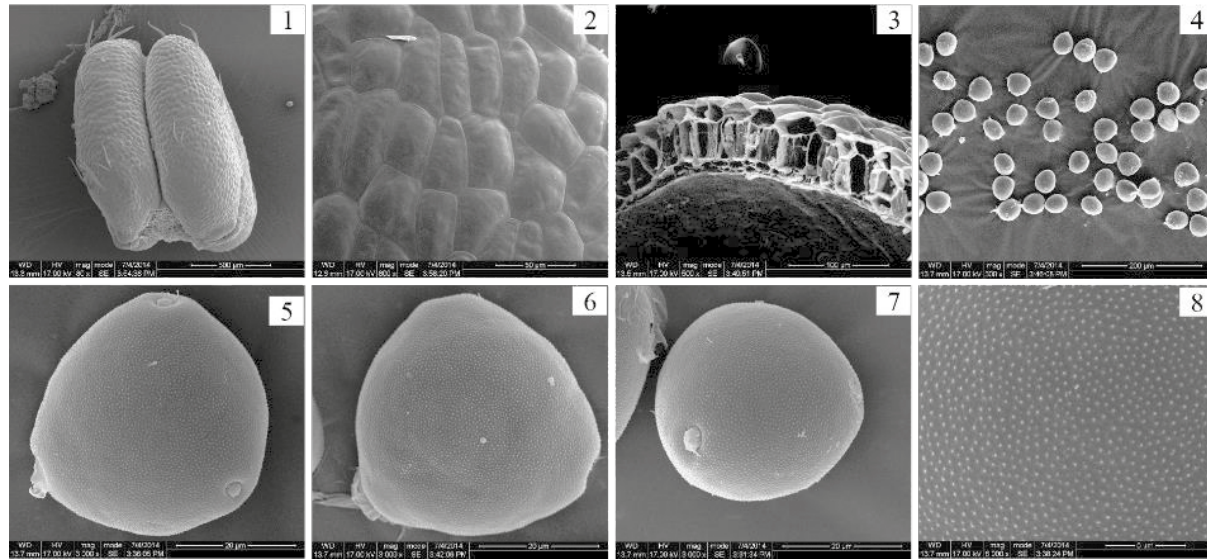
Figure 7. Scanning electron microscopic observation of pollen sac of pecan. 1) Overall appearance of anther. 2) Pollen sac surface. 3) Pollen sac wall anatomical structure when shedding pollen. 4) After pollen sac cracking, pollen group photo. 5) Pollen side view. 6) Pollen polar view. 7) Pollen equatorial plane view, showing micropyle. 8) Pollen surface